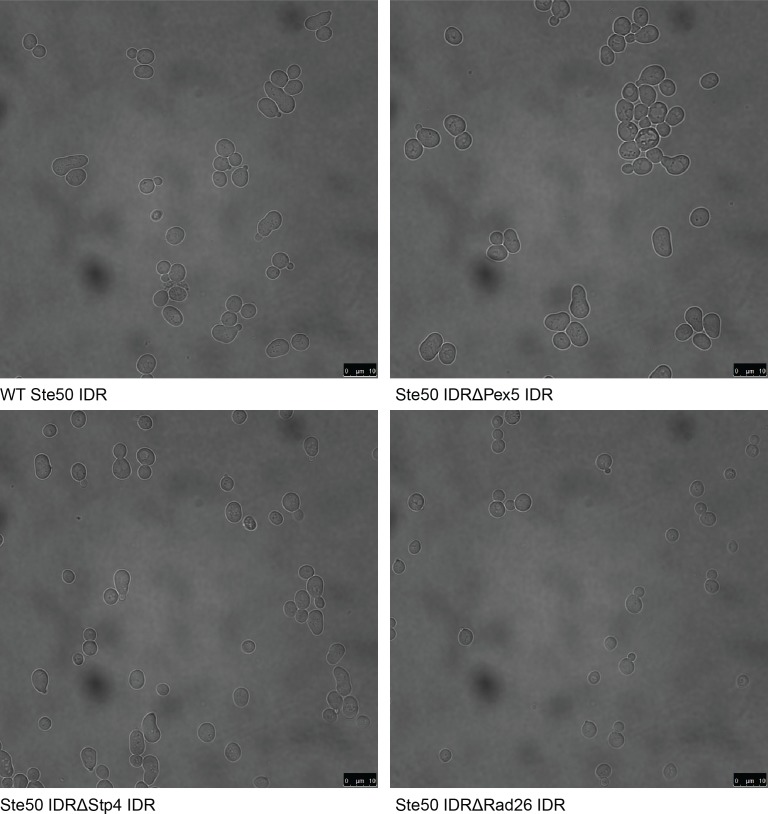
Full field-of-view micrographs of pheromone-exposed S. cerevisiae strains from Figure 2C.